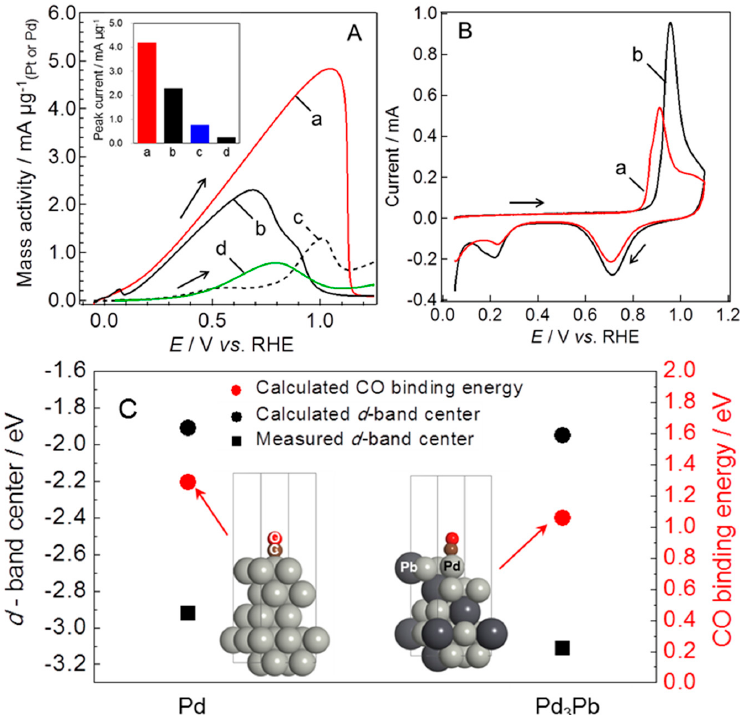
Figure 4. ( A ) Linear sweep voltammograms for oxidation of formic acid on (a) intermetallic Pd 3 Pb electrochemically treated for 50 cycles, (b) Pd, (c) Pt and (d) Pt–Ru alloy. ( B ) Cyclic voltammograms for CO stripping over (a) Pd 3 Pb electrochemically treated for 50 cycles and (b) Pd. ( C ) Experimentally measured (black square) and density functional theory (DFT) calculated (black circle) d-band centers for Pd and intermetallic Pd 3 Pb structures. Reproduced with permission [31]. Copyright 2017, American Chemical Society.